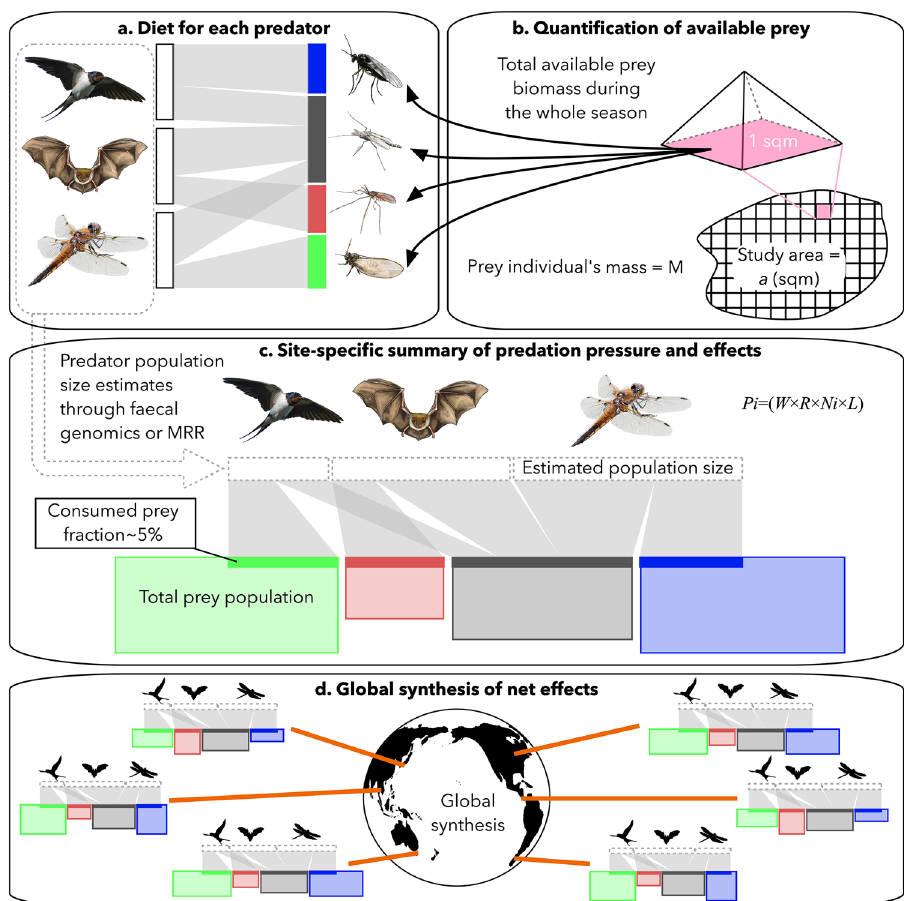
Figure 3. The roadmap to global insect-insectivore interactions and their potential effects on an ecosystem. To summarize the above-mentioned new focus, one needs to ( a ) describe the diet and measure population sizes for each predator. This can be achieved by applying calibrated molecular methods and relative read abundances (for RRA, see 28 ). Predator population sizes may optimally be estimated directly from faecal DNA, using repeated sampling and population-genetic tools 56 . Secondly, one should ( b ) quantify the prey populations using area- standardized sampling methods, e.g. utilizing rearing traps and prey individual’s mass should be defined to estimate the total prey biomass. Thirdly, ( c ) these data should be combined with individual predator mass W , daily consumption rate R , predator population size N i , and the estimated longevity of each individual predator L in the following equation: P i = ( W × R × N i × L ) to calculate the species-specific consumption for each predator. For rationale and a detailed description of the equation, see 17 . Finally, ( d ) this pipeline should be replicated worldwide, to synthesize the global net effect for both predators and prey in the era of biodiversity crisis. Photo credits: Kari Kaunisto (bird picture in a , c ), Anna Blomberg (bat drawing in a , c ), Tuomas Kankaanpää (dragonfly picture in panels a and c prey insects in a , c ), and Maija Laaksonen (bat silhouette in d ). All other pictures by Eero